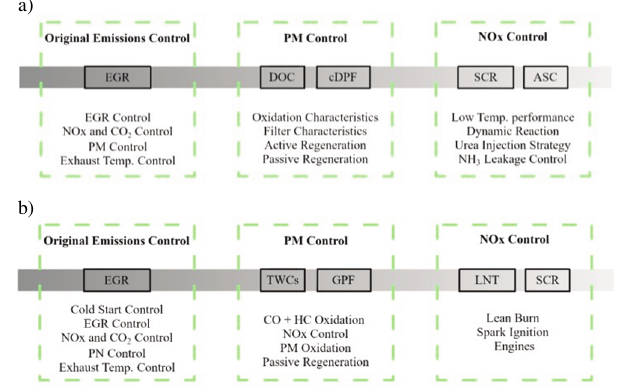
Fig. 1. Technical points of a) diesel engine after treatment system; b) gasoline DI engine after treatment